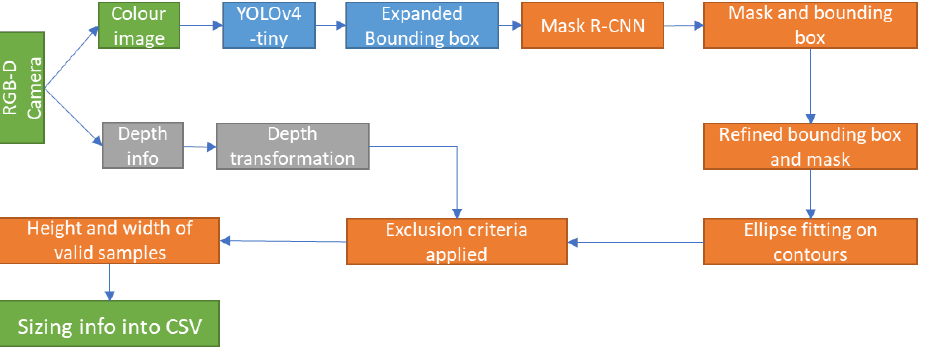
Figure 7. Method 3 – Mask R-CNN segmentation within YOLOv4-tiny detected bounding boxes. Figure 7. Method 3–Mask R-CNN segmentation within YOLOv4-tiny detected bounding boxes.